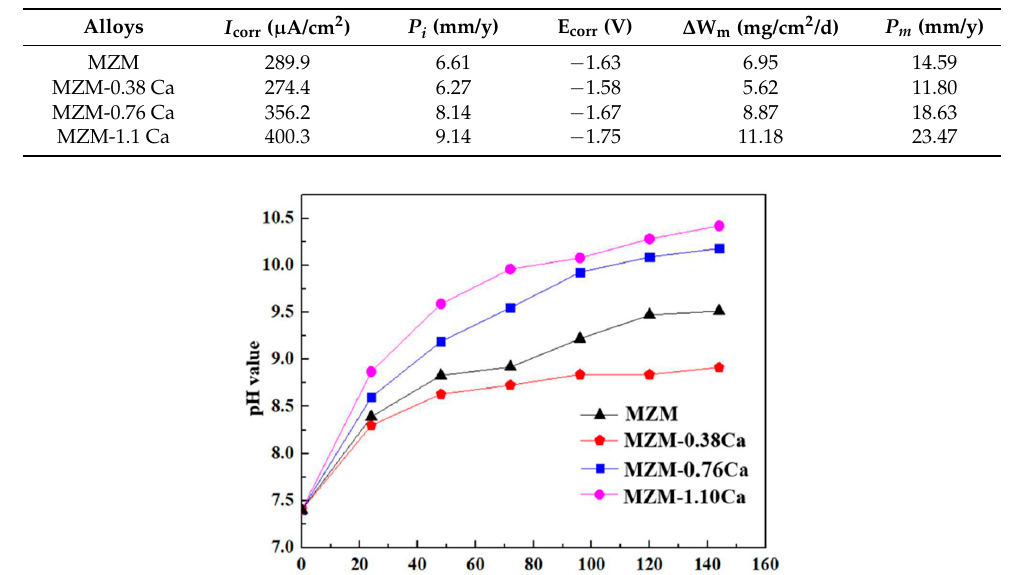
Figure 9. 3D corrosion morphology of MZM-xCa alloys with homogenization treatment: ( a ) 0%; ( b ) 0.38%; ( c ) 0.76%; and ( d ) 1.10%. Table 4. Measurements related to corrosion rate in simulated body fluid at 37 °C.